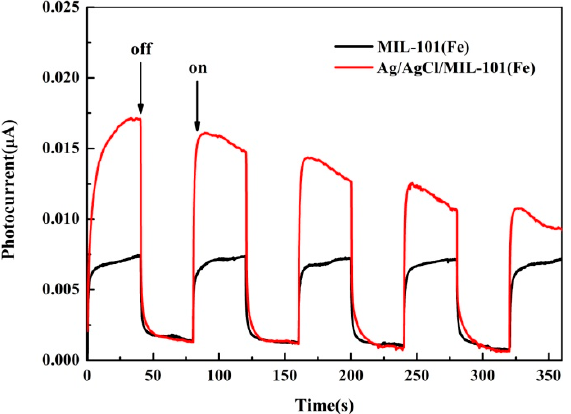
Figure 16. Transient photocurrent responses of Ag/AgCl/MIL ‐ 101(Fe) and MIL ‐ 101(Fe).